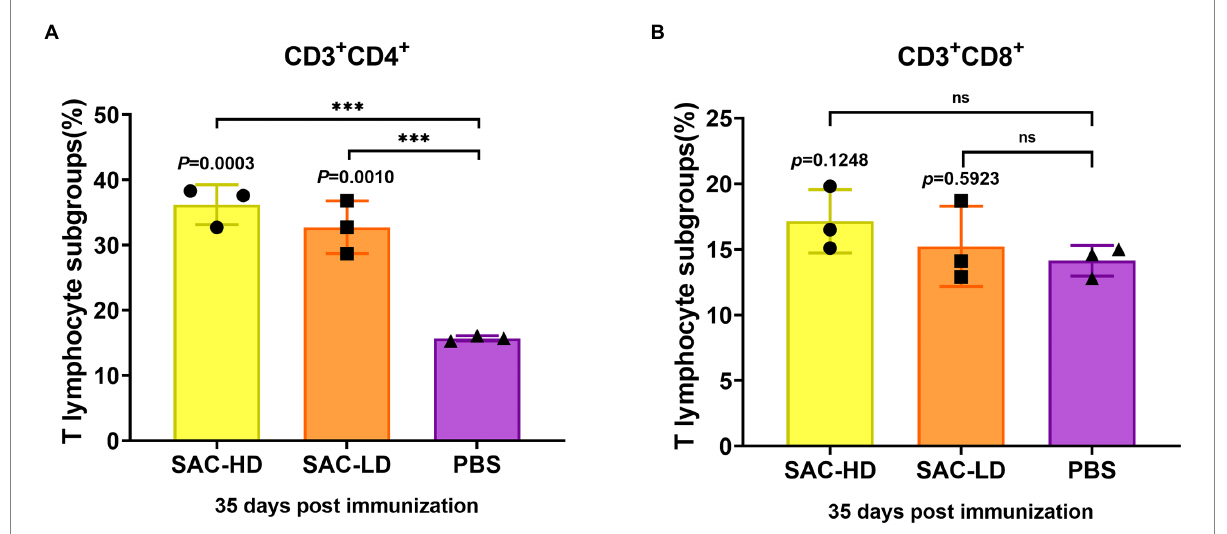
FIGURE 5 Activation of NiV-sG-specific Th/Tc cells after immunization with candidate vaccine at 28 dpi. (A) Data shows the frequency of CD3 + CD4 + T lymphocytes. (B) Data show the frequency of CD4 + CD8 + T lymphocytes. The lymphocytes were obtained from the PBMCs of pigs; five dots represent five biological replicates, Error bars represent standard deviation from the mean of five replicate values (* p < 0.05, ** p < 0.01, *** p < 0.001, **** p < 0.0001). The Student t test was used to analyze significant differences between the